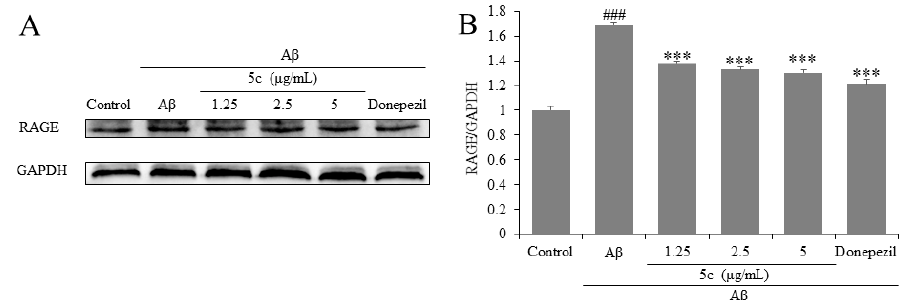
Figure 8. Effects on receptor for AGE (RAGE) of compound 5c in PC12 cells induced by A β 25-35 . ( A ) The protein levels of RAGE were detected by Western blotting. ( B ) Quantification of RAGE expression is presented in bar graphs. ### p < 0.001 vs. control group; *** p < 0.001 vs. model group.